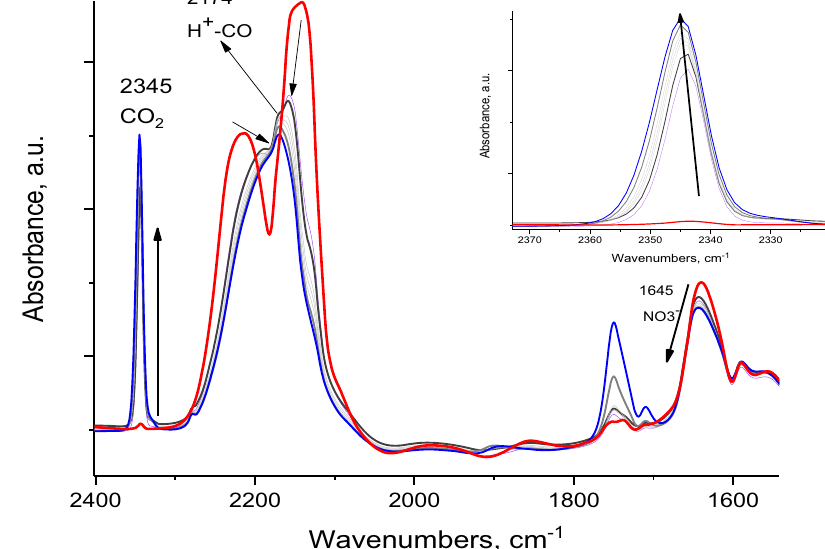
Fig. 3 Monitoring CO oxidation with FTIR. In-situ FTIR during an increase of temperature from 100 K (red line, described in Fig. 2a, H-SSZ-13 with Si/Al ~12) to 135 K. At this temperature CO 2 starts to evolve and the temperature is held until CO 2 reaches the maximum level (~2 min). The inset shows the magni fi ed CO 2 region. Note that we collected spectra at temperatures intermediate between 100 and 135 K, and no CO 2 formation was detected until 135 K. Zeolite pellet itself was used as IR (IS) structure (Zeo1ite/CO/HNO 3 ) the C – O vibrational frequency was calculated to be 2175 cm − 1 , in line with the corresponding isms. In the former, the CO molecule is oxidized by the HNO 3 via